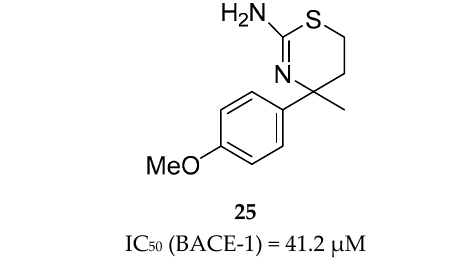
Figure 23. HTS aminothiazine fragment hit 25 .